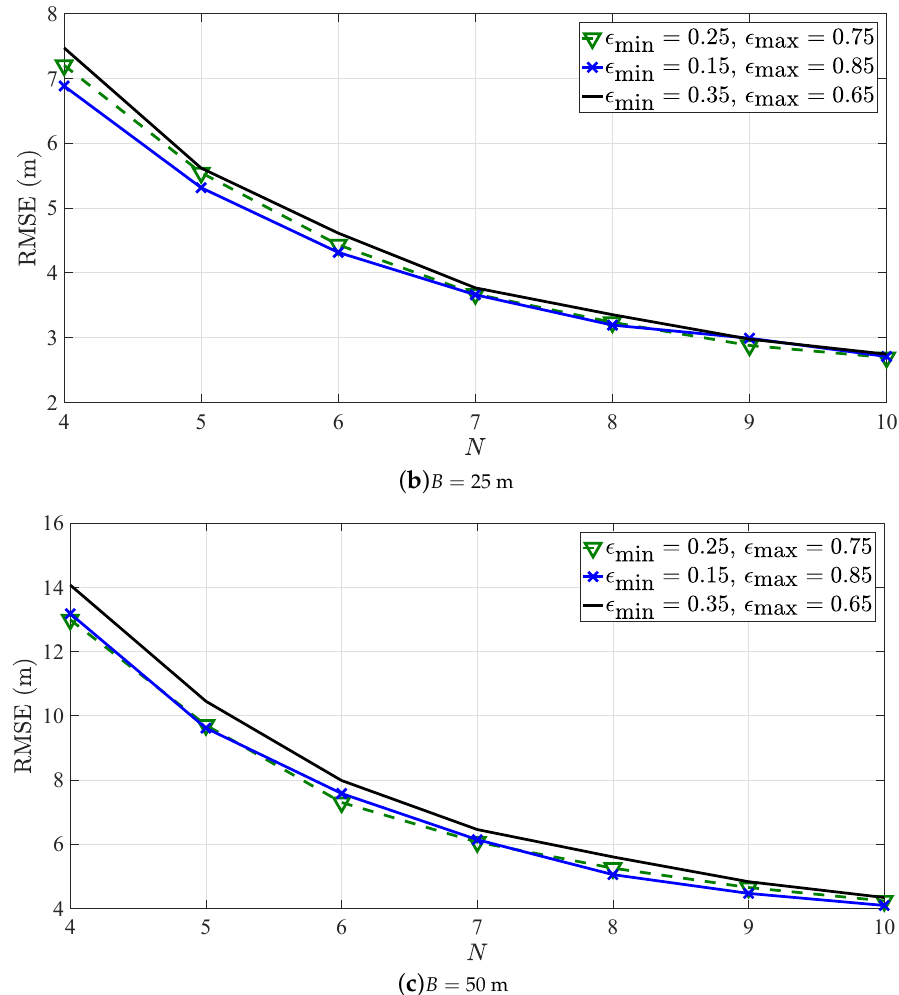
Figure 7. RMSE versus N comparison for SR-WLS for different limits for (cid:101) in the first considered